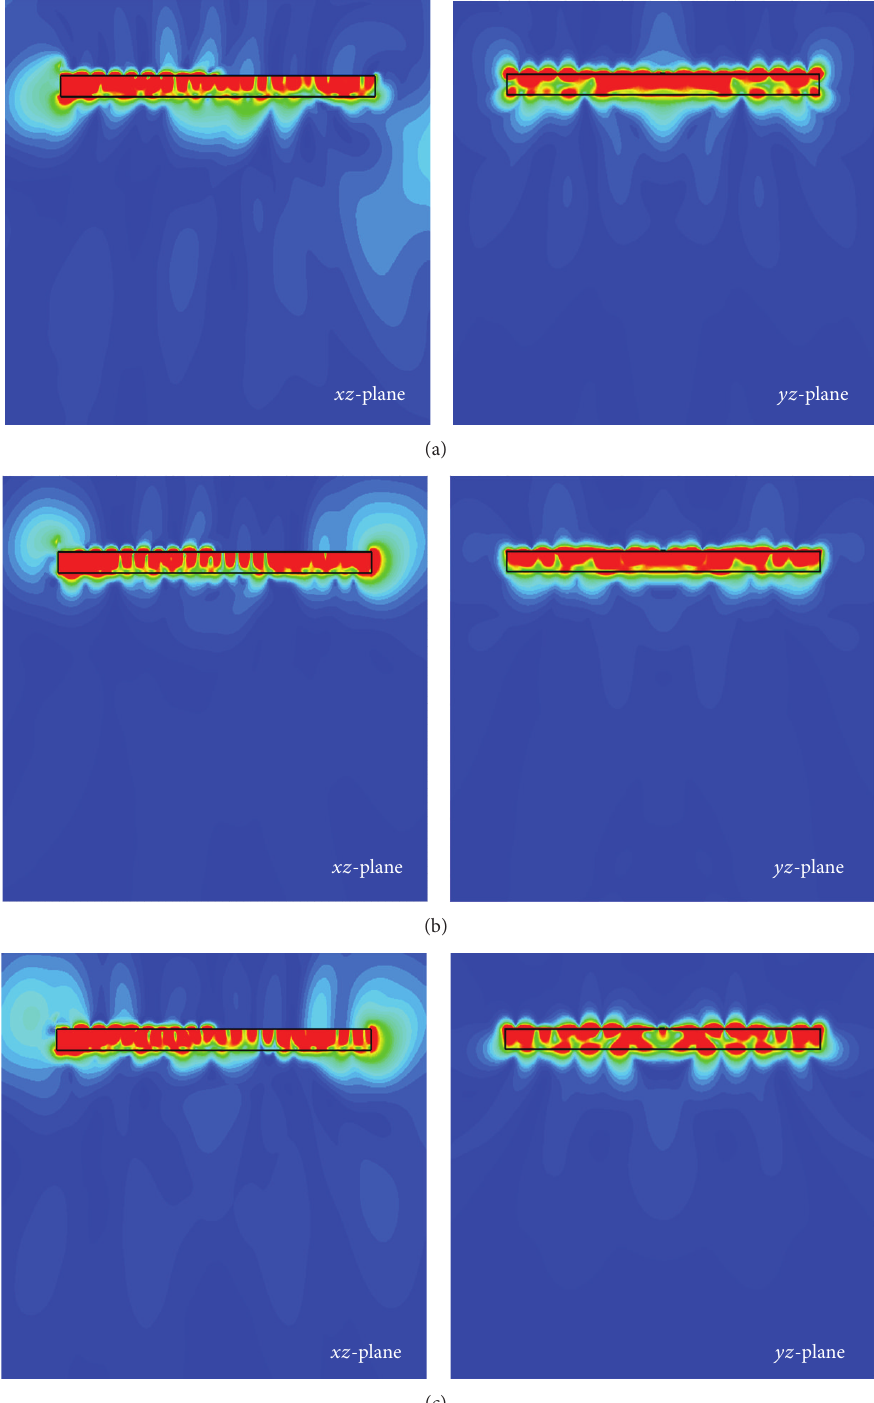
Figure 3: E-field distributions of the leaky-wave slit fed by a coplanar waveguide in the absence of the FSS hole array: (a) 21.5 GHz, (b) 21.7 GHz, and (c)